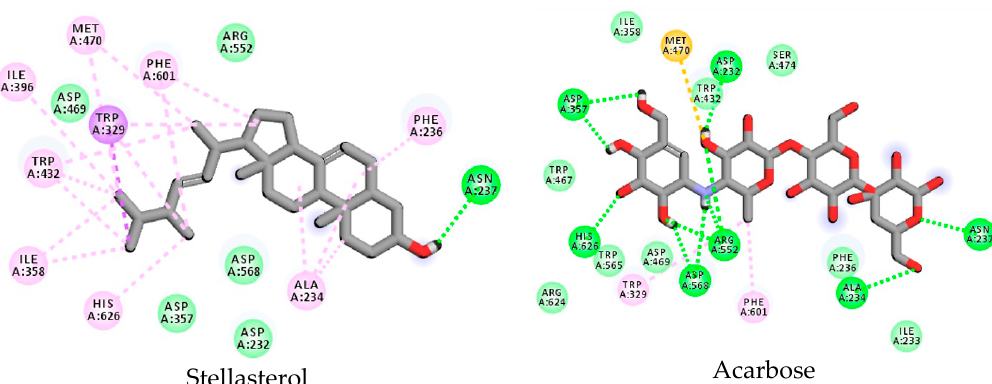
Figure 3. The binding mode 2D view of the α -glucosidase enzyme with stellasterol and acarbose.